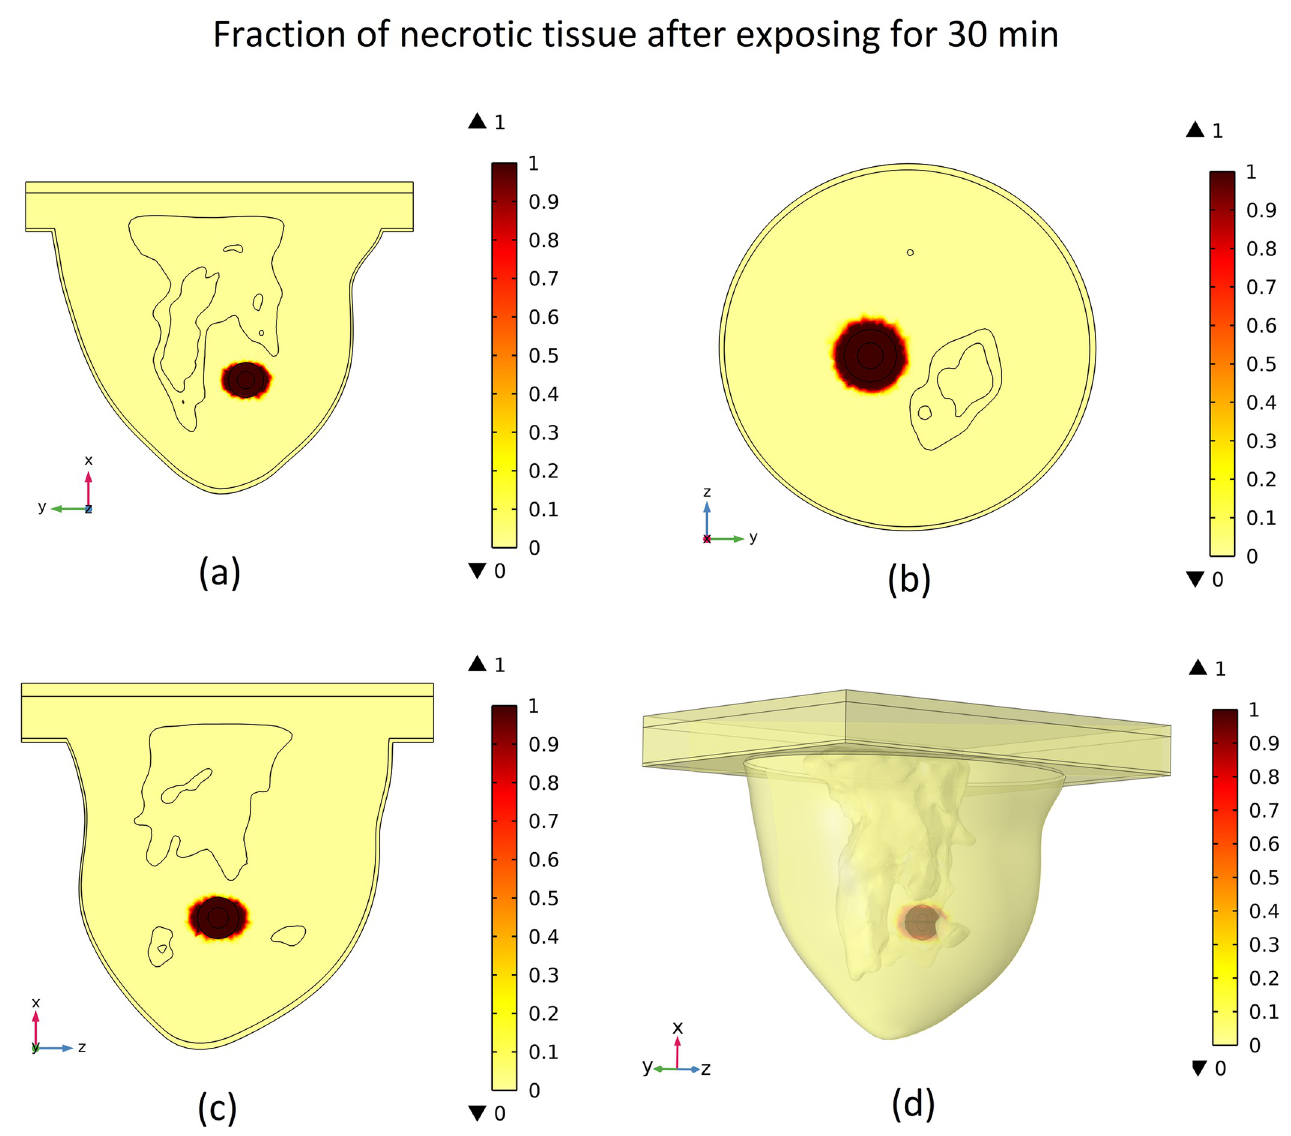
Fig 17. Distribution of fraction of necrotic tissue after 30 minutes of exposure to the magnetic field, (a) cut surface 1, (b) cut surface 2, (c) cut surface 3, (d) 3D view.